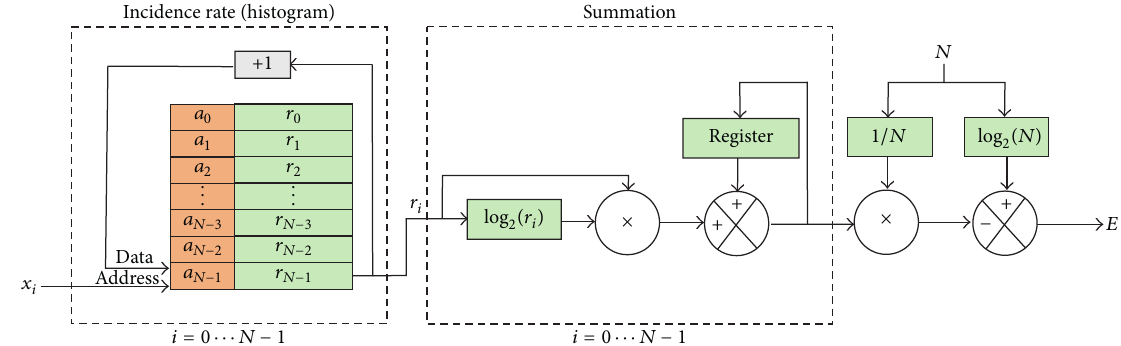
Figure 1: General structure for the entropy